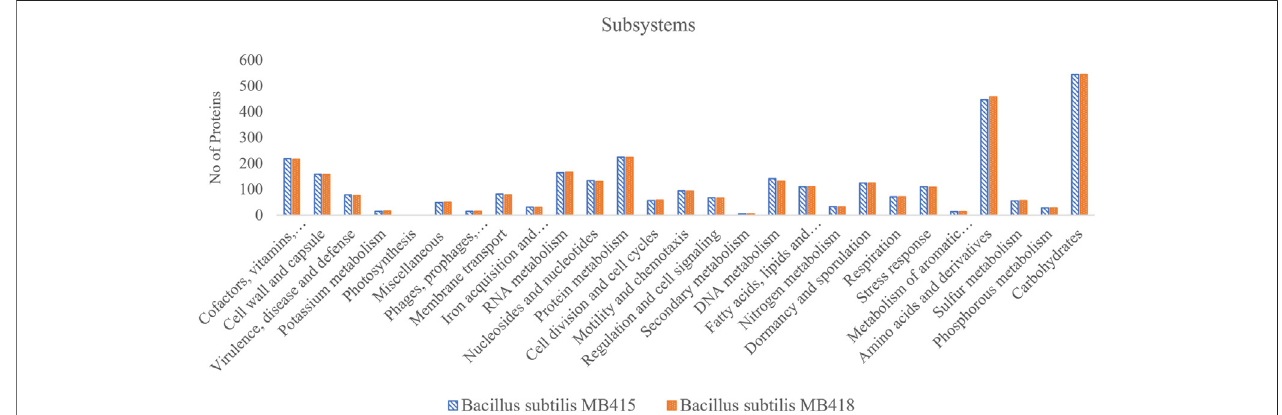
FIGURE 2 | Subsystem features of the two Bacillus subtilis strains (MB415 and MB418).